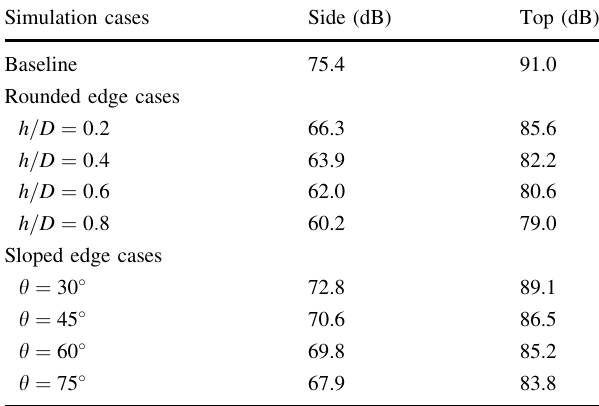
Table 3 OASPL at the side and the top receiver positions Simulation